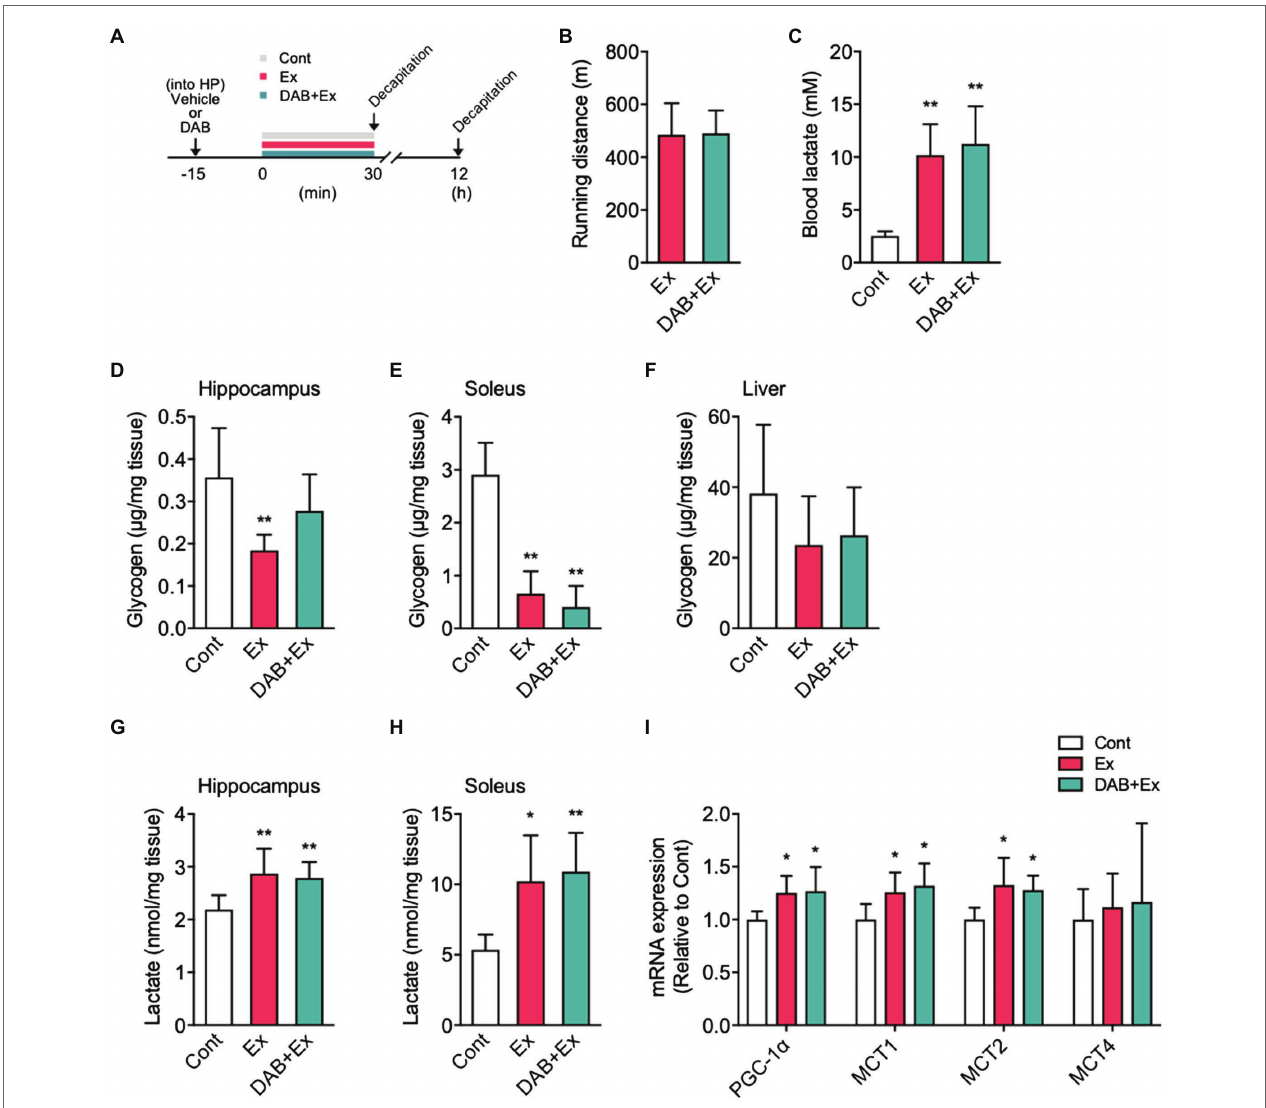
FIGURE 5 | The effects of intra-hippocampal 1,4-dideoxy-1,4-imino-D-arabinitol (DAB) injection before high-intensity exercise on hippocampal glycogen, lactate levels, and PGC-1 α , MCTs mRNA expression. (A) Experimental design: Mice were injected saline or DAB by intra-hippocampal injection 15 min before a single bout high-intensity exercise by using a micro-injection pump. (B) Running distance to fatigue on a treadmill for mice administered vehicle (Ex) or DAB (DAB + Ex) before exercise. (C) Blood lactate concentrations immediately after exercise and control. (D) Glycogen levels in the hippocampus, (E) soleus muscle (F) liver, (G) lactate levels in the hippocampus, and (H) soleus muscle immediately after exercise, with vehicle (Ex) or DAB (DAB + Ex) and control (Cont, n = 6; Ex, n = 6; DAB + Ex, n = 6). (I) PGC-1 α , MCTs mRNA expression in the hippocampus 12 h after a single bout of high-intensity exercise (Cont, n = 6; Ex, n = 7; DAB + Ex, n = 7). All data were presented as the mean ± SD values. Data were analyzed using one-way ANOVA with Tukey’s post-hoc tests. * p < 0.05 and ** p < 0.01 compared to Cont